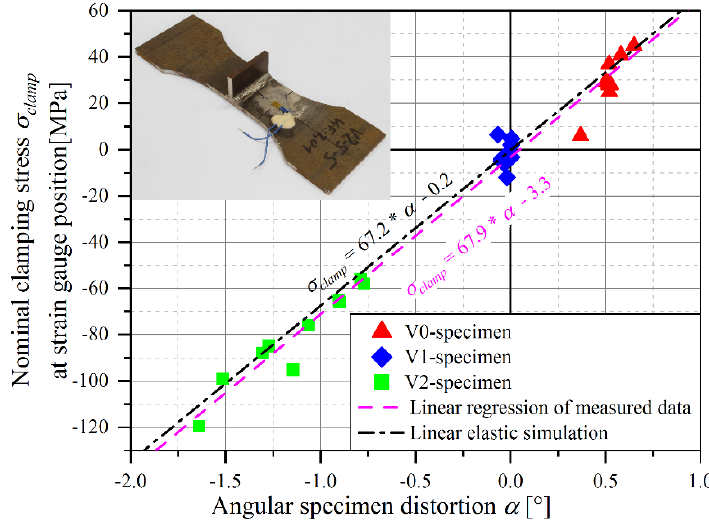
Figure 6. Correlation of clamping stress and angular specimen distortion.